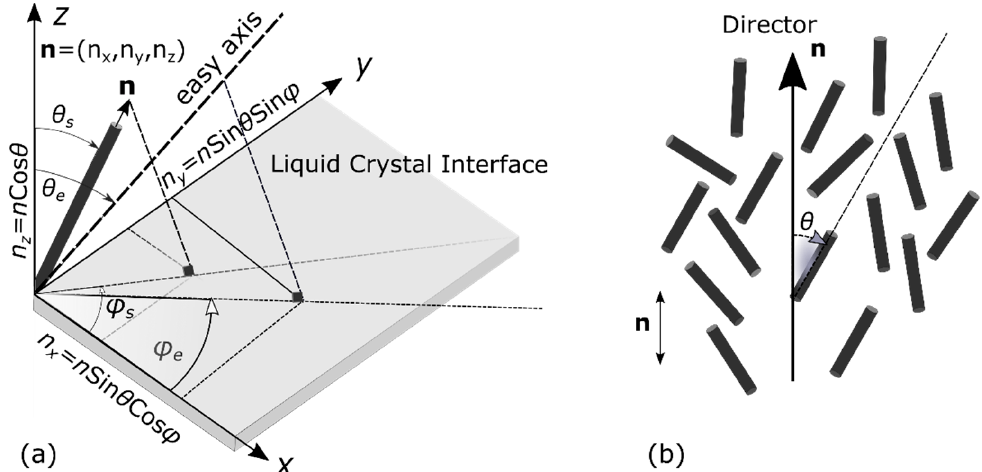
Figure 2. Schematic representation of director. ( a ) The director field and easy axis are defined in Cartesian coordinate system. ( b ) The molecular order of liquid crystal shows molecules are statistically aligned along a preferred axis called the director field.